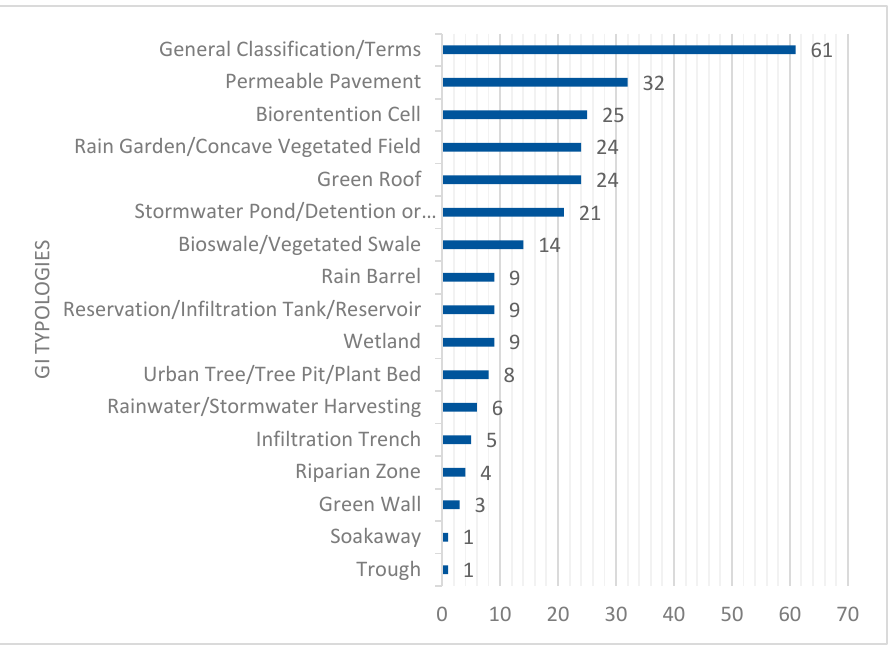
Figure 5. GI typologies used in the reviewed literature.